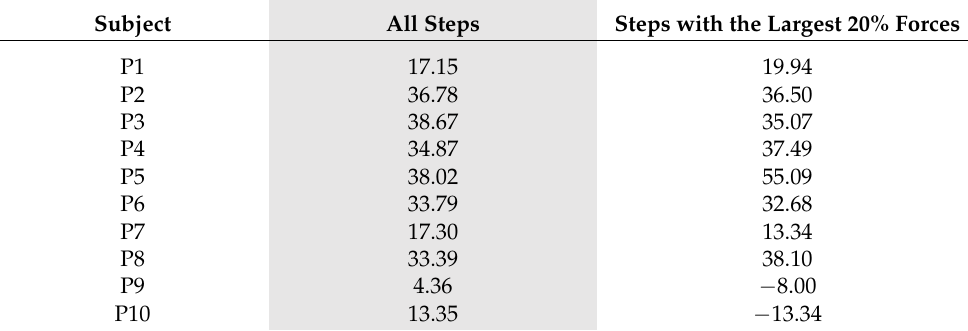
Table A2. Comparison of the asymmetry of swing